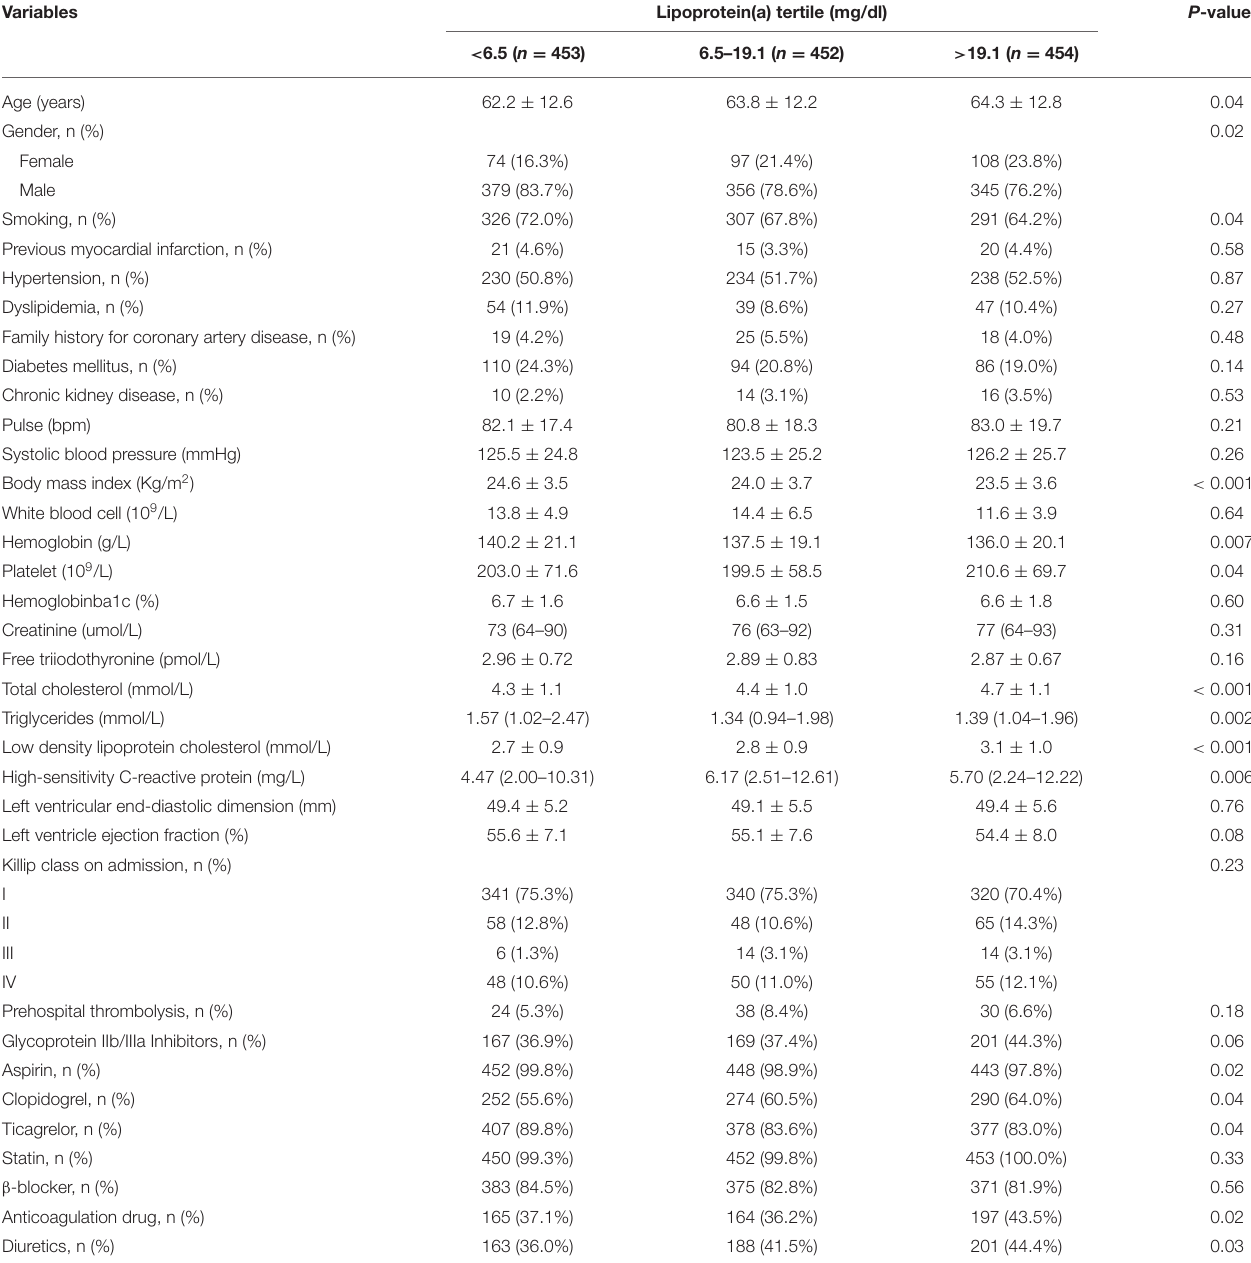
TABLE 1 | Baseline characteristics by tertiles of lipoprotein(a) level.